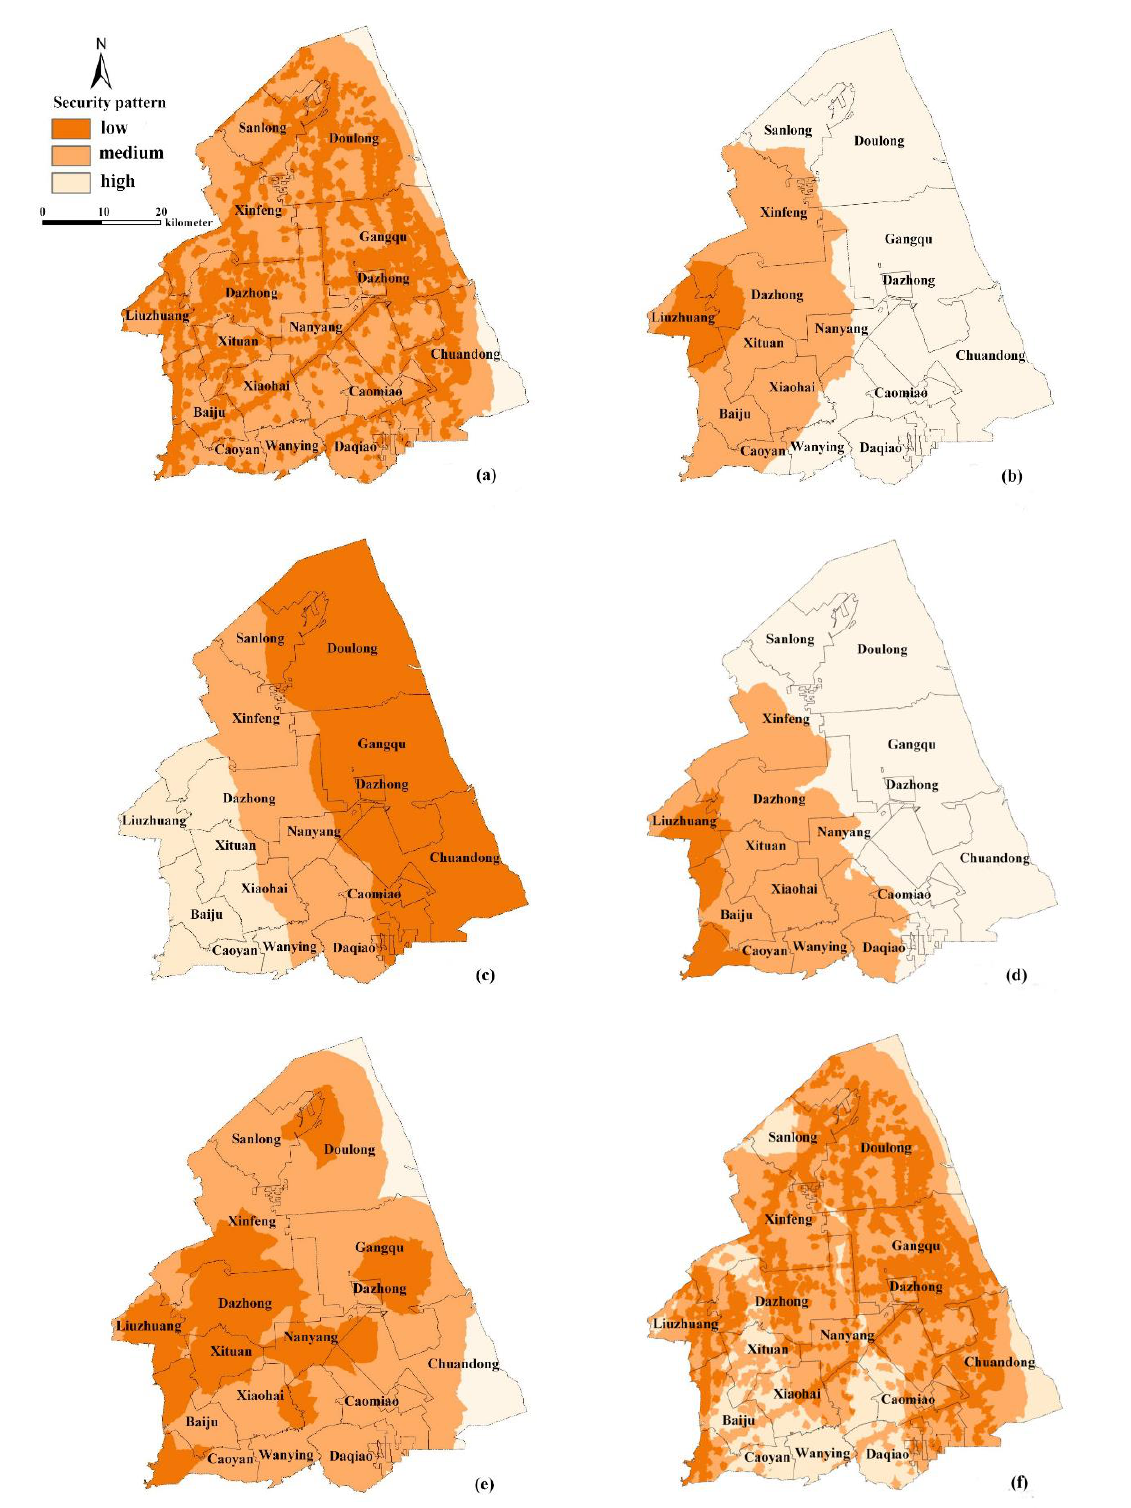
Figure 3. ( a–f ) Landscape security pattern. ( a ) water-soil conservation security pattern, ( b ) water source protection security pattern, ( c ) biodiversity conservation security pattern, ( d ) local culture protection security pattern, ( e ) recreation security pattern, ( f ) comprehensive security pattern.